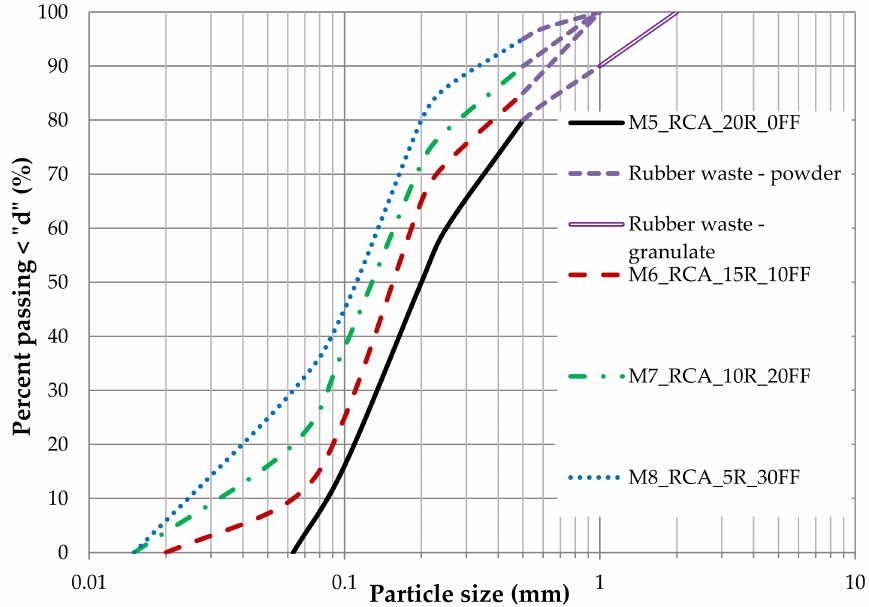
Figure 5. The particle size distribution curves of M5, M6, M7, and M8 used for this